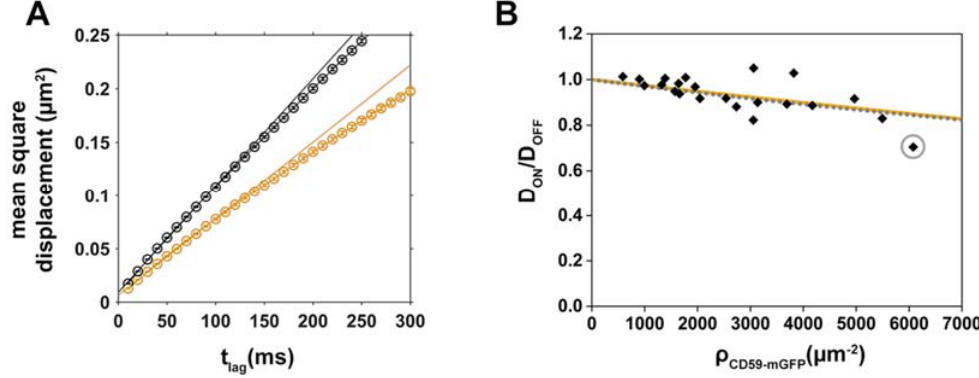
Figure 2. Mobility of the cholesterol analog Chol ‐ PEG ‐ KK114 decreases with increasing CD59 ‐ mGFP surface density. ( A ) Mean square displacements (msd) of “ON” (orange) and “OFF” (black) CD59 ‐ mGFPI areas are plotted as a function of t lag for one representative cell. Diffusion coefficients were determined by fitting the function msd = 4Dt lag + 4 σ xy2 ; ( B ) Relative diffusion coefficients D ON /D OFF were determined for individual cells ( N = 22), plotted as a function of CD59 ‐ mGFP density, ρ CD59 ‐ mGFP , and fitted with Equation (2) (steric obstacles, orange line) or Equation (1) assuming a combined size of tracer and obstacle d = 2 nm (binding, dotted grey line). The gray circle indicates the cell shown in ( A ).